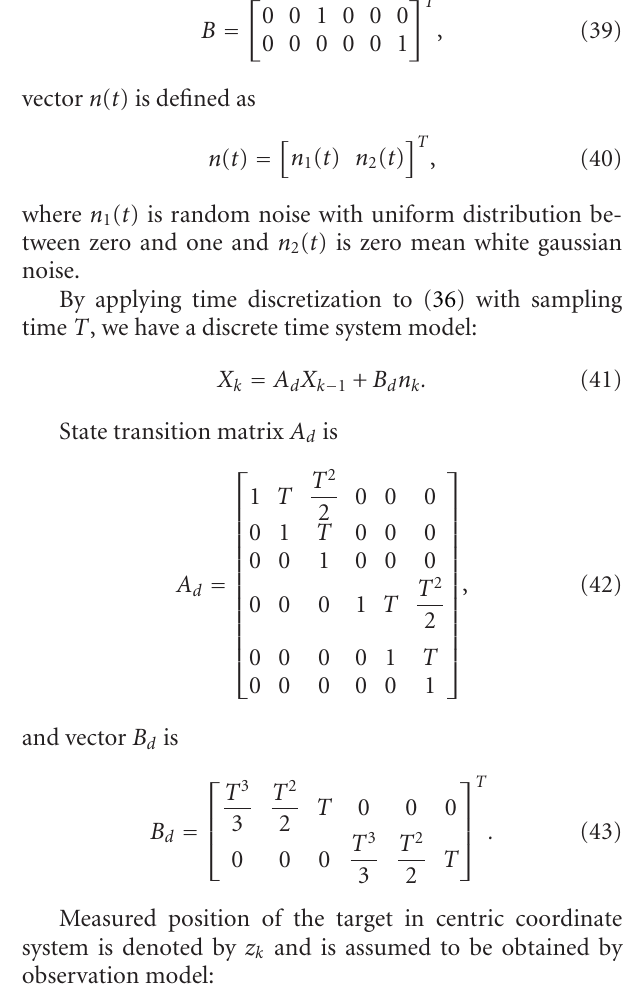
Kalman filter is used to estimate parameters of asymmet- ric gate that are considered in part 3. Actual and estimated values of r x ( t ), s x ( t ), and a x ( t ) in centric coordinate system are shown in Figure